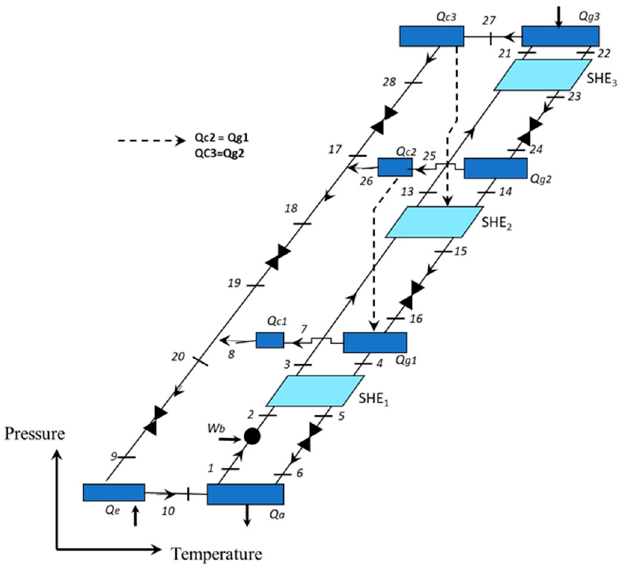
Figure 4. Schematic diagram of a triple-effect absorption cooling system.